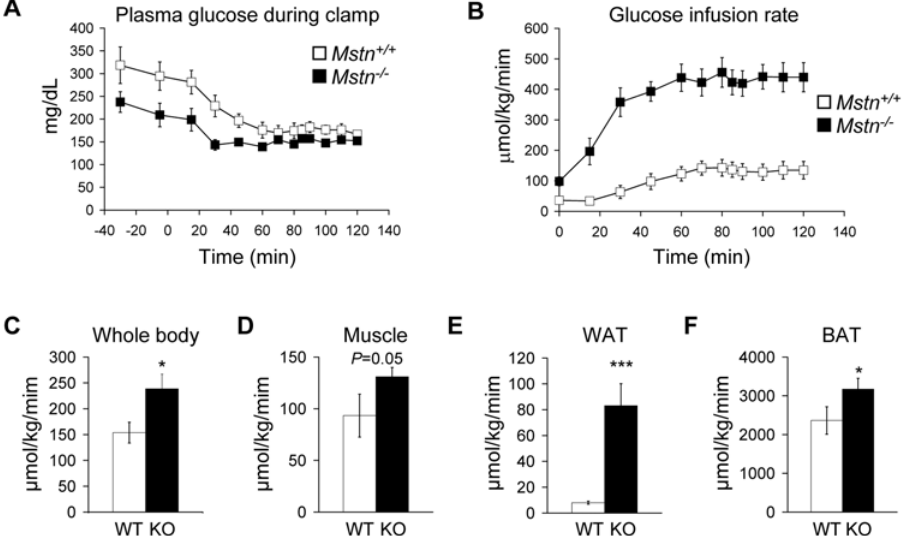
Figure 3. Mstn 2 / 2 mice have increased glucose uptake by hyperinsulinemic-euglycemic clamp. ( A ) Plasma glucose concentration before and during clamp. Insulin was infused at time 0. ( B ) Glucose infusion rate during clamp. Glucose uptake in ( C ) whole body, ( D ) skeletal muscle, ( E ) WAT, and ( F ) BAT. n =7–8. * P , 0.05, *** P , 0.001.